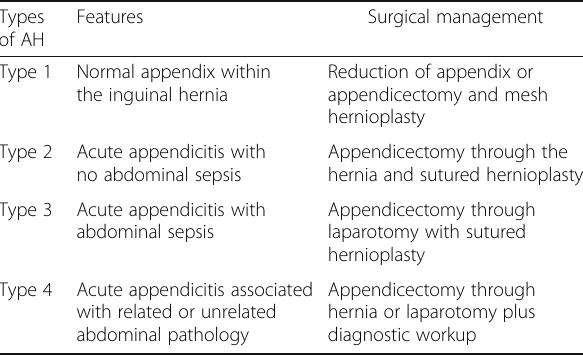
Table 2 Losanoff – Basson classification of Amyand ’ s hernia (AH) and their management